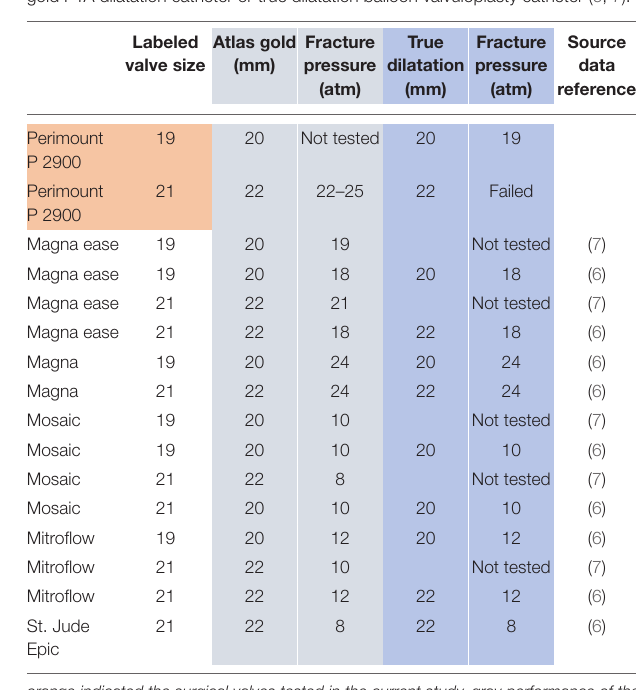
orange indicated the surgical valves tested in the current study. gray performance of the Atlas Gold balloon in in-vitro BVF studies. blue performance of the True dilatation balloon in in-vitro BVF